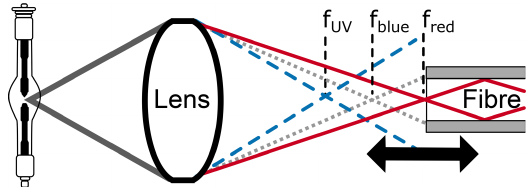
Figure 5. Principle of selectively coupling light from a light source into a fibre for stray-light reduction using the chromatic aberration of the lens. The foci of different spectral regions can be attained by a translation of the fibre along the optical axis of the lens.